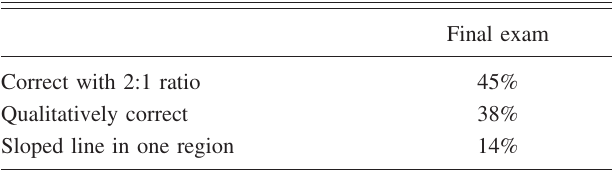
TABLE IV. Student responses on the final examination balls-on- ramps question, N =44.